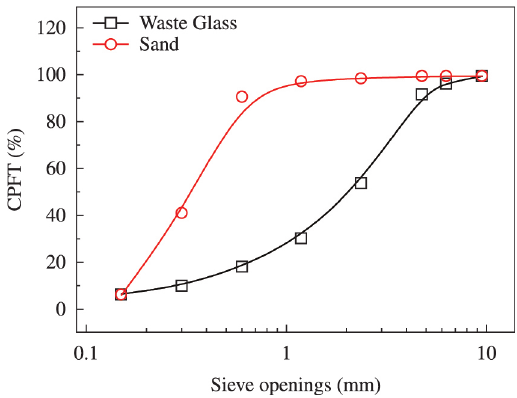
Figure 1. Comparative particle size distribution of sand and waste glass.